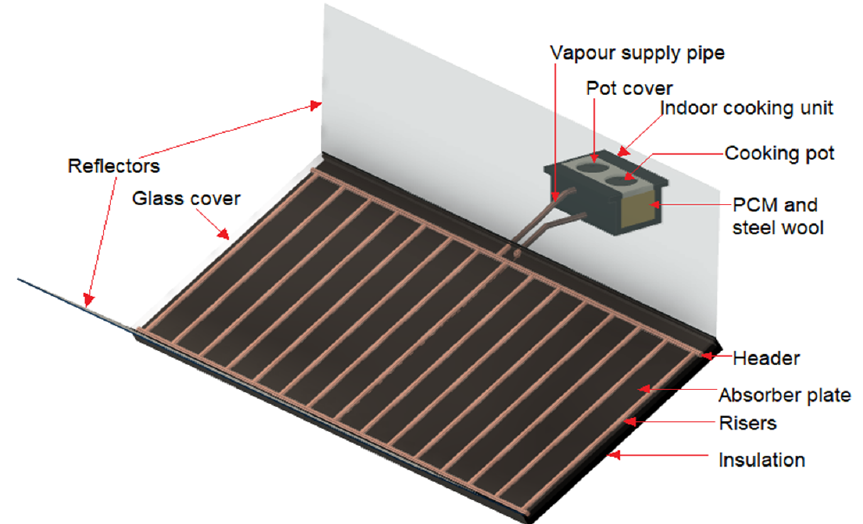
Figure 1. Wickless heat pipes flat solar plate collector with an indoor cooking unit. Reprinted/adapted with permission from (2008), Hussein et al.